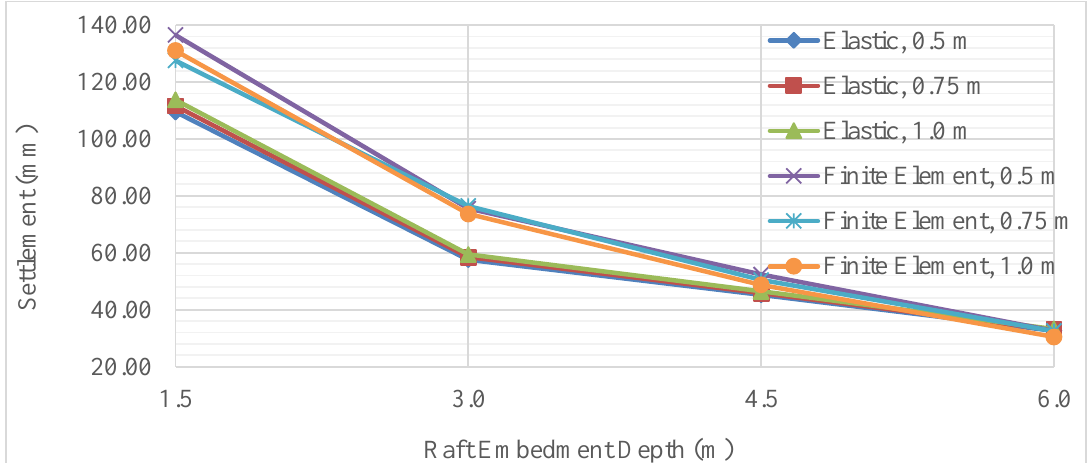
Fig. 15. Settlement versus depth showing the effect of raft thickness for 500 kN/m 2